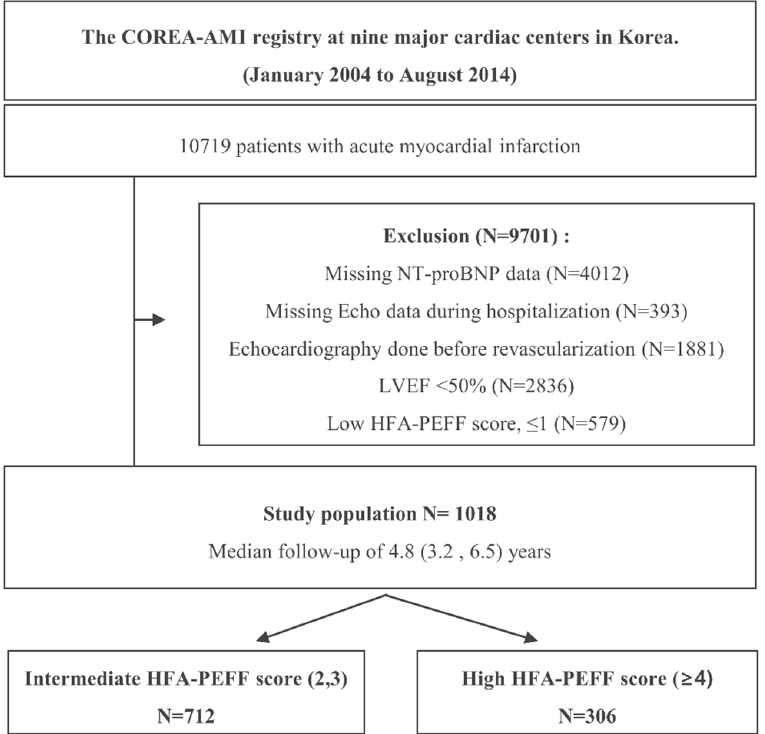
Figure 1. Study flowchart. Abbreviations: NT-proBNP, N-terminal pro b-type natriuretic peptide; LVEF, left ventricle ejection fraction.